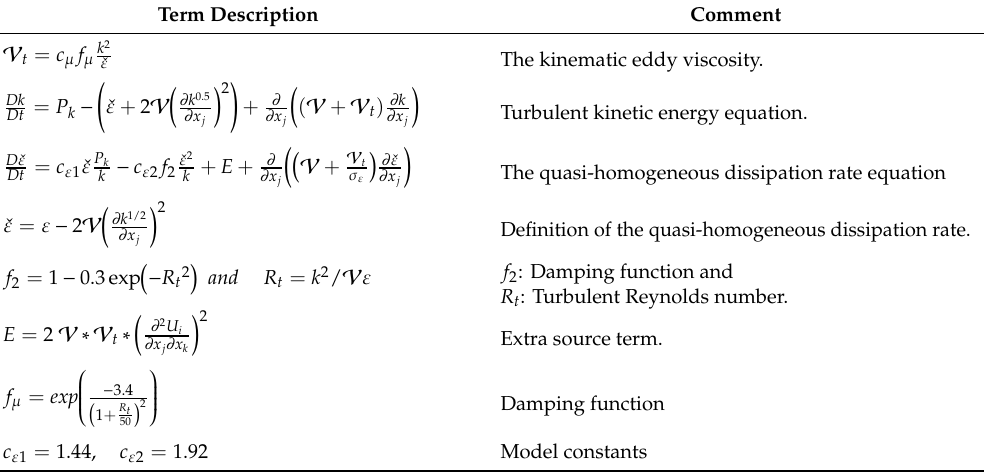
Table 4. Description of the Launder and Sharma k- ε model, Equations taken from Launder and Sharma [38]. Term Description Comment